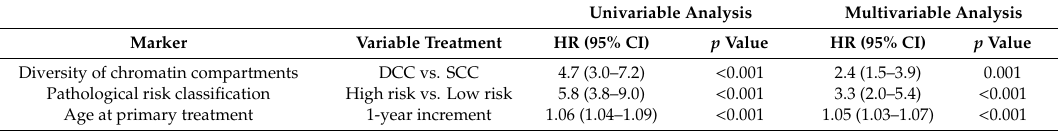
Table 3. Analyses of cancer-specific survival for patients with endometrial carcinoma.